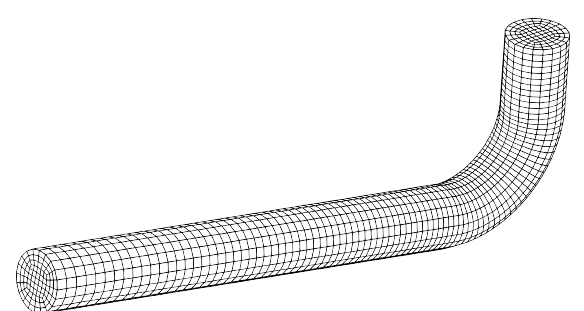
Figure 5. Cutout of model mesh near the low-point of the riser.